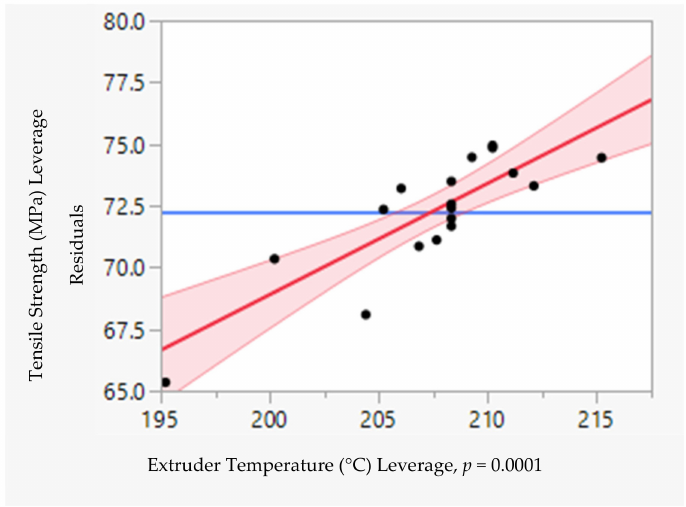
Figure 14. Tensile strength vs. extruder